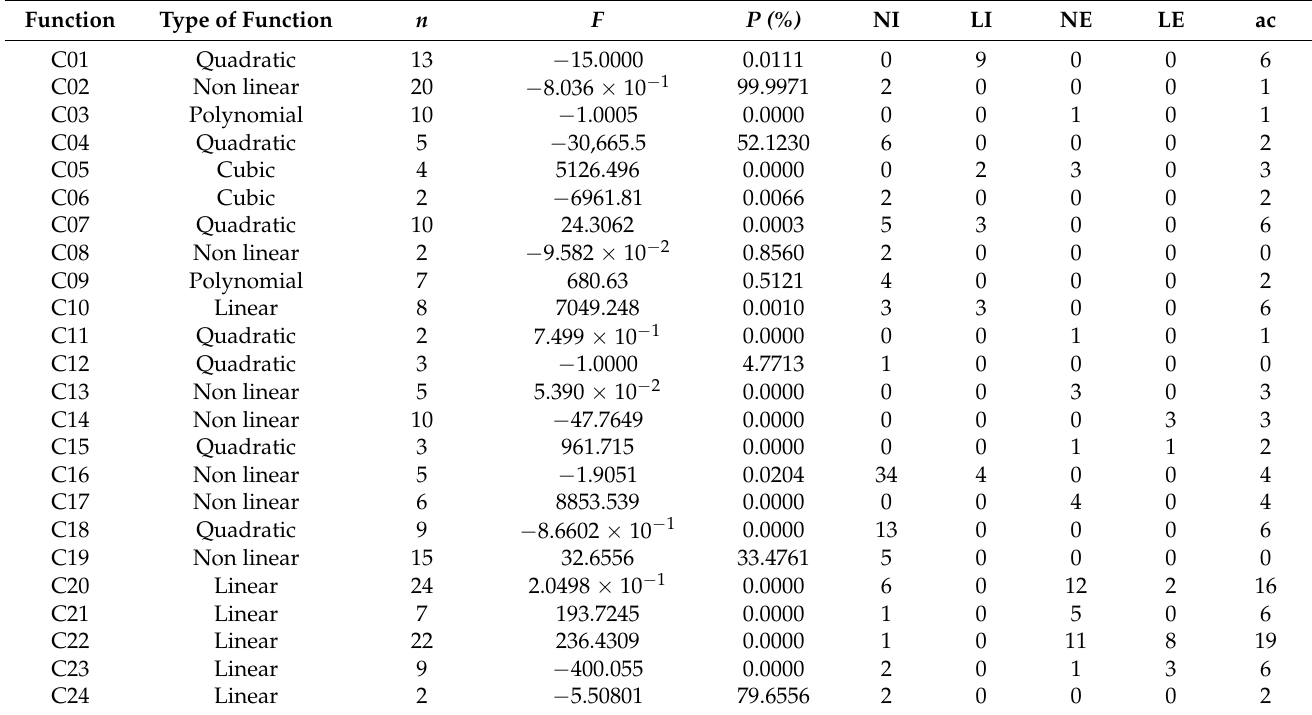
Table 1. The characteristics of 24 COPs used in the investigation. n denotes the number of decision variables; F indicates the global optimum value; P (%) indicates the estimated ratio between the search space and the feasible domain; NI represents the number of non-linear inequality constraints; LI denotes the number of linear inequality constraints; NE denotes the number of non-linear equality constraints; LE indicates the number of linear equality constraints, and ac represents the number of active constraints at the optimum